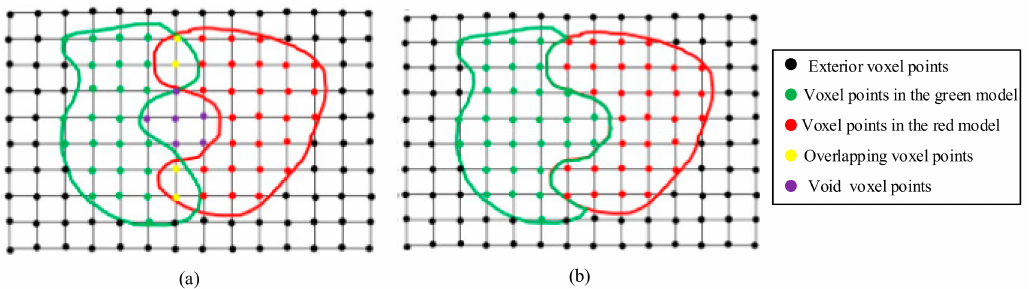
Figure 1. Schematic diagram of model repair. ( a ) Original voxel points. ( b ) Repaired voxel